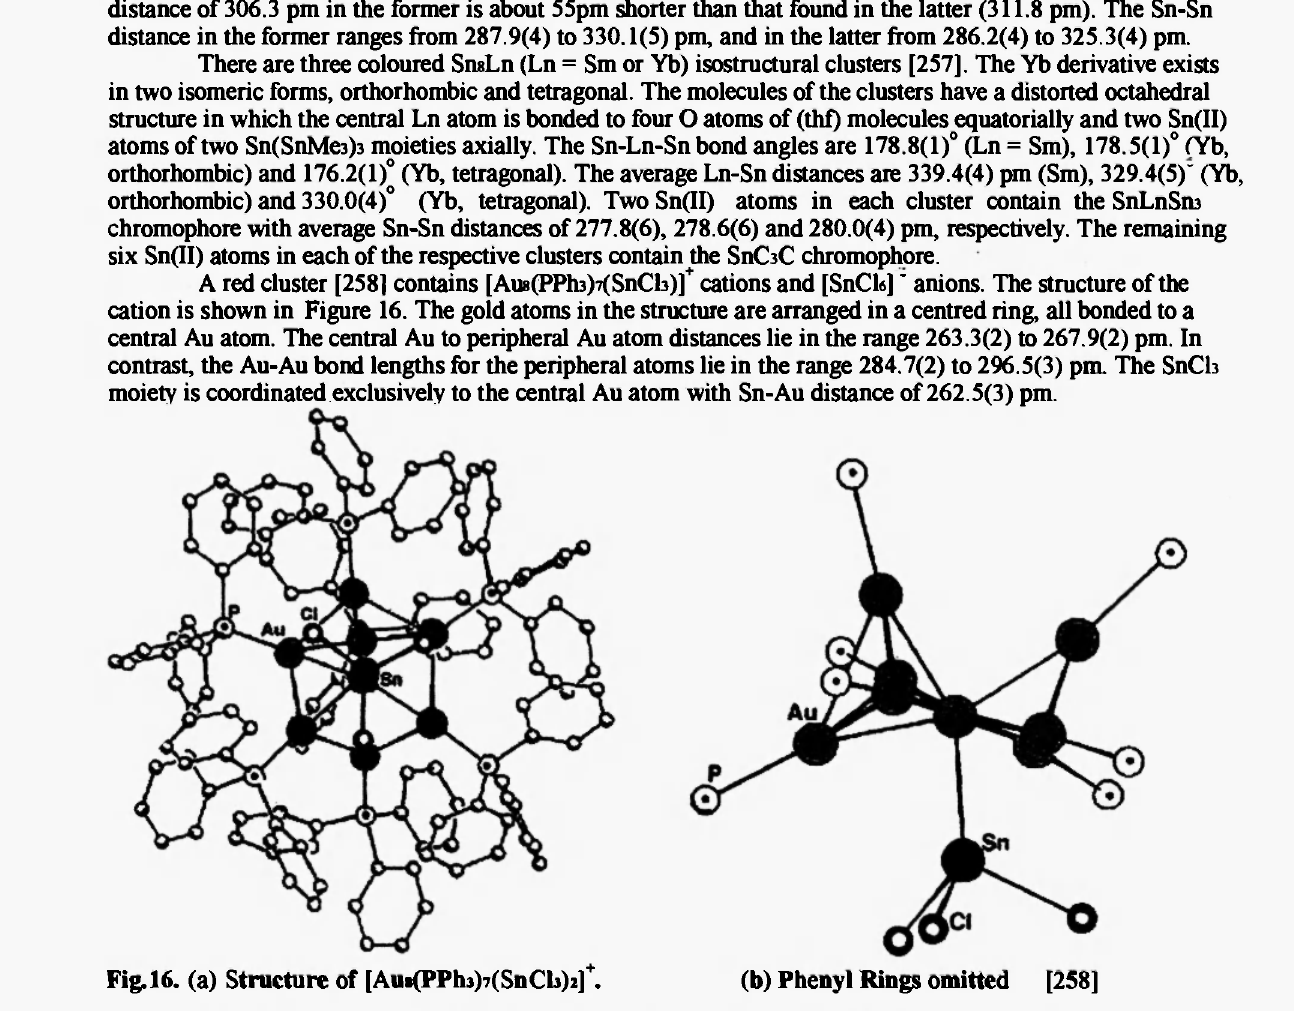
Fig. 16. (a) Structure of [Au<PPh